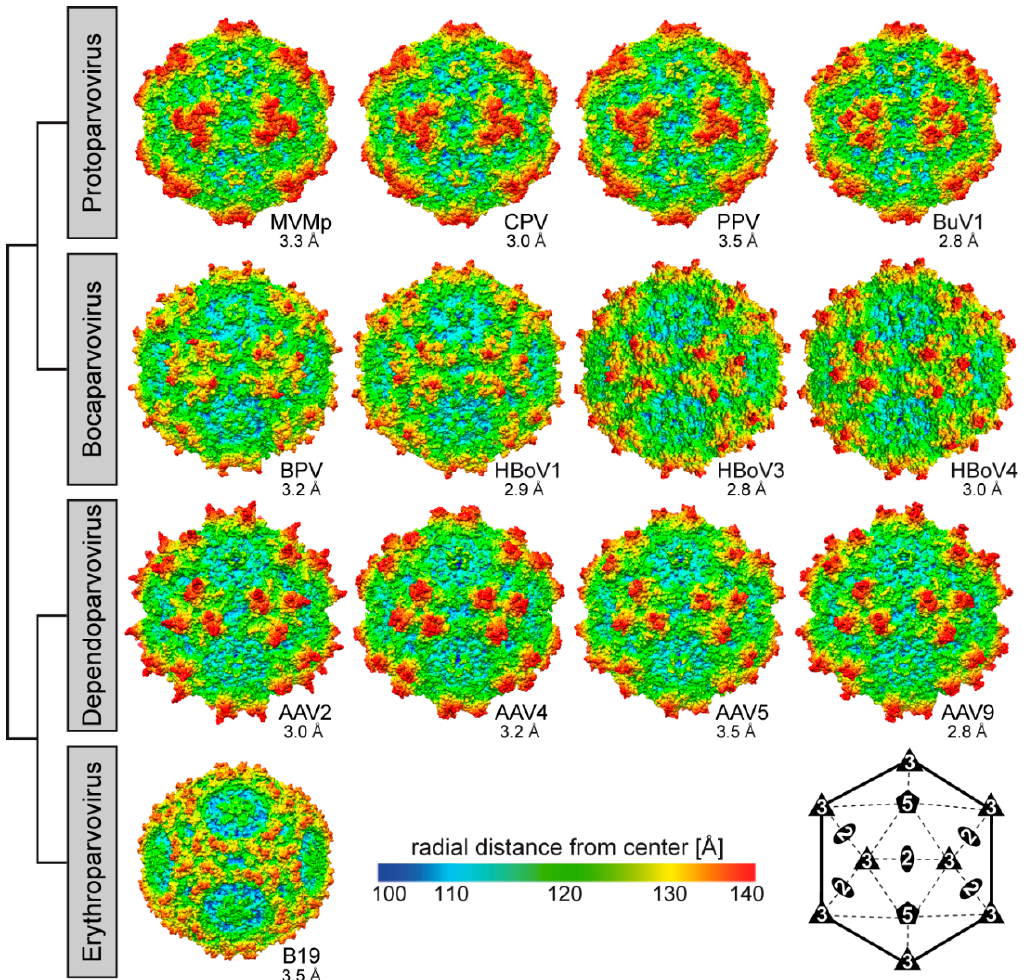
Figure 8. Capsid structures of the Parvovirinae subfamily. A selection of capsid structures is shown for Protoparvovirus , Bocaparvovirus , Dependoparvovirus , and Erythroparvovirus . The capsid surfaces are viewed down the icosahedral 2 ‐ fold axes and are colored according to radial distance from the particle center (blue to red), as indicated by the scale bar. The capsid images were generated using Chimera [78]. In the lower right hand side, a symmetry diagram illustrating the positions of the icosahedral symmetry axes on the capsid surfaces is shown.